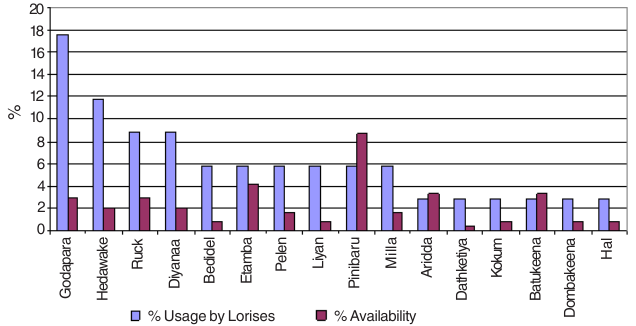
Figure 1. Tree availability at Kottawa Arboretum and frequency of utilization by L.t. tardigradus (n = 34)